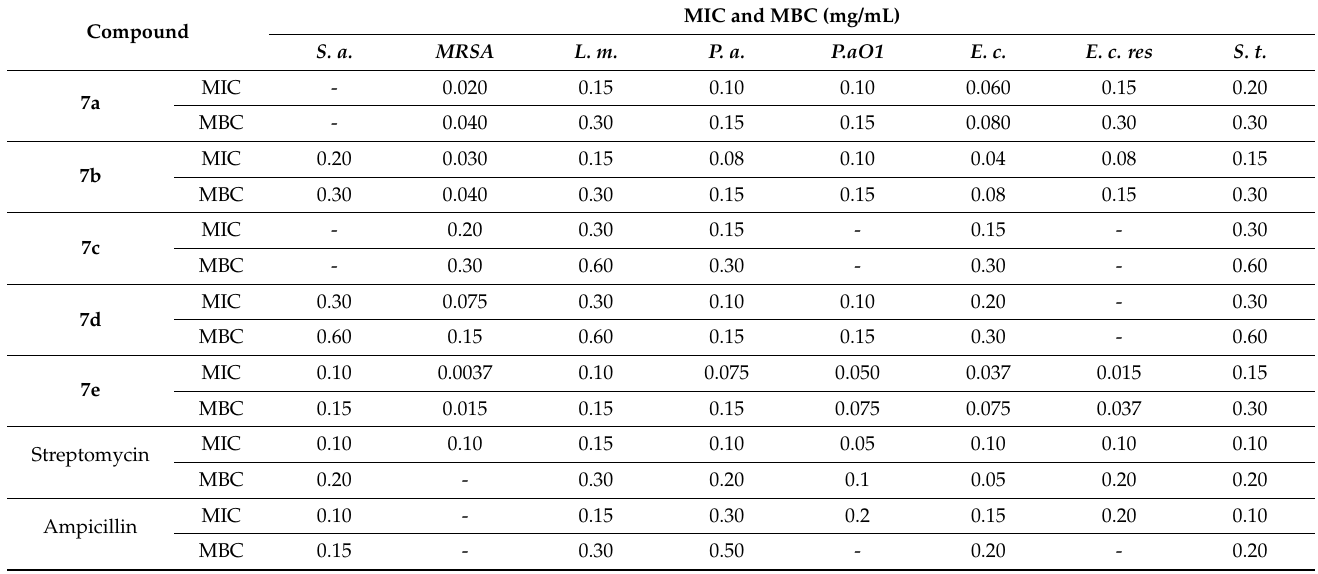
Table 8. MIC and MBC (mg/mL) values of the synthesized androstane oxime derivatives. Adapted from [86].